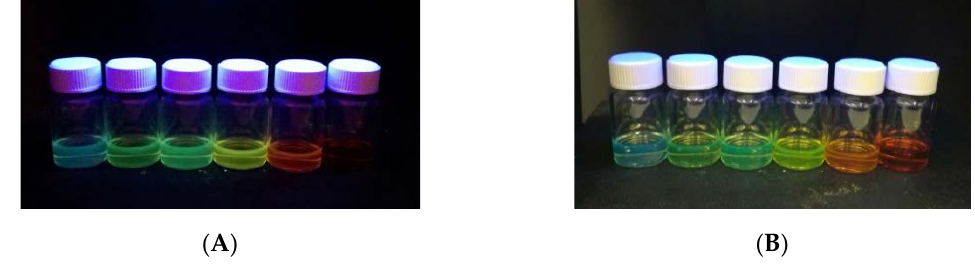
Figure 4. Luminescence photographs of P1 – P2 in CHCl 3 , upon excitation at 254 nm ( A ) and 365 nm ( B ). From left to right, the order of the compounds in the photograph is: P1a , P1b , P1d , P1c , P2b , and P2c .